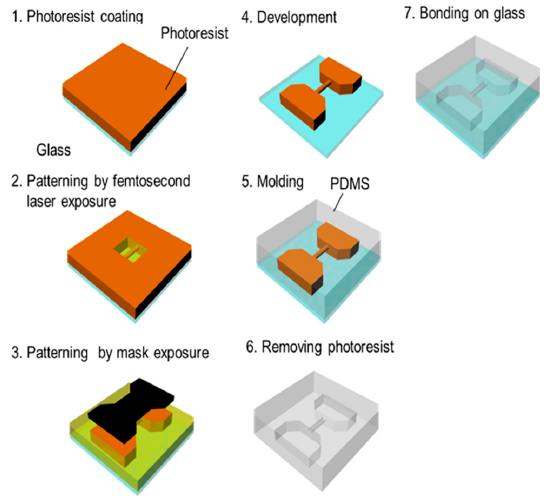
Figure 7. Microchannel model fabrication process using femtosecond laser and mask hybrid exposure (FMEx).